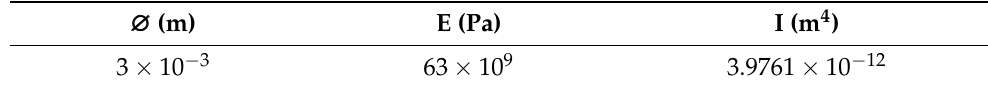
Table 3. Properties of the flexible